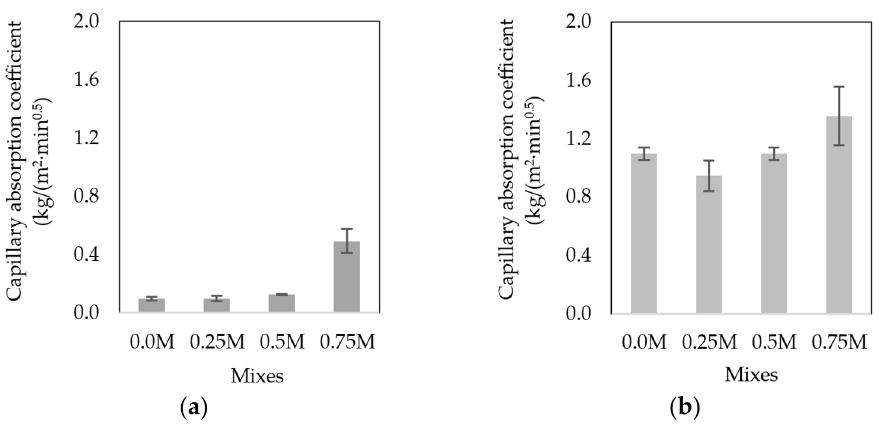
Figure 15. Capillary absorption coefficients of CAA mortars: ( a ) between 10 and 90 min; and ( b ) between 90 and 4320 min.